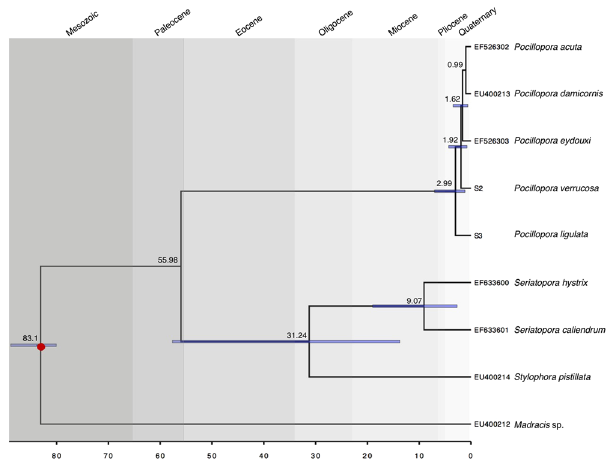
Figure 5. Reduced mitochondrial genome time-calibrated phylogeny consisting of protein coding regions (COX1: 1,549 bp; ND5 CDS: 12,937 bp; large ribosomal subunit: 1,972 bp; ATP8: 220 bp; total: 16,678 bp) of Pocillopora estimated using BEAST v2.3.2. The node represented with a red dot was time constrained by the first appearance of Madracis ( M. johnwellsi ) in the fossil record during the upper Campanian 30 (72.1–83.6 mya). Values above nodes are median node ages and blue node bars represent the 95% highest posterior density interval of node